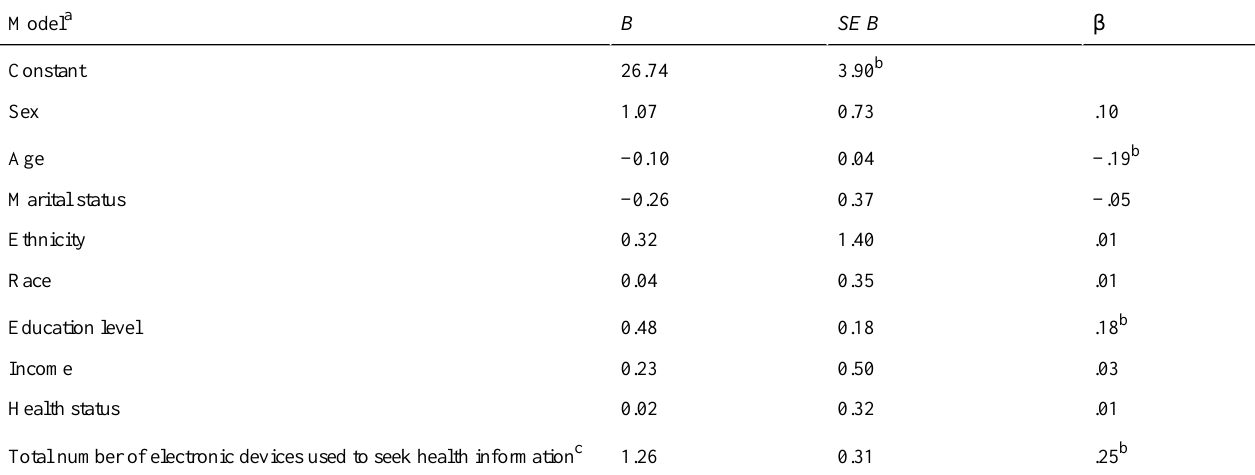
Table 3. Multiple linear regression predicting eHealth literacy